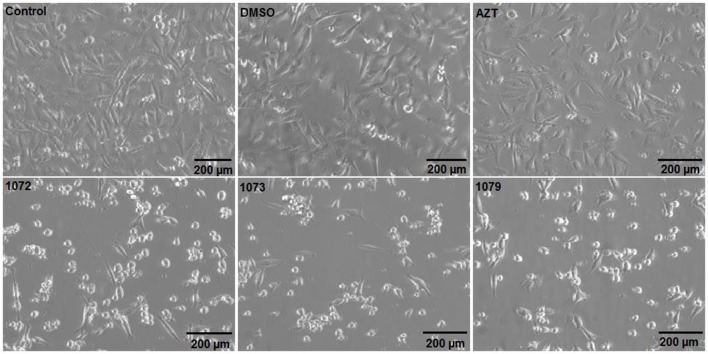
Morphological analyzes after treatment with AZT or derivatives. The tumor cell line MDA-MB 231 was incubated without treatment (control) or with 50 μM of AZT or derivatives (1072, 1073, and 1079) during 48 h. Cells treated with AZT derivatives showed morphology similar to apoptotic cells, with cell shrinkage and lose of cell-cell contact.